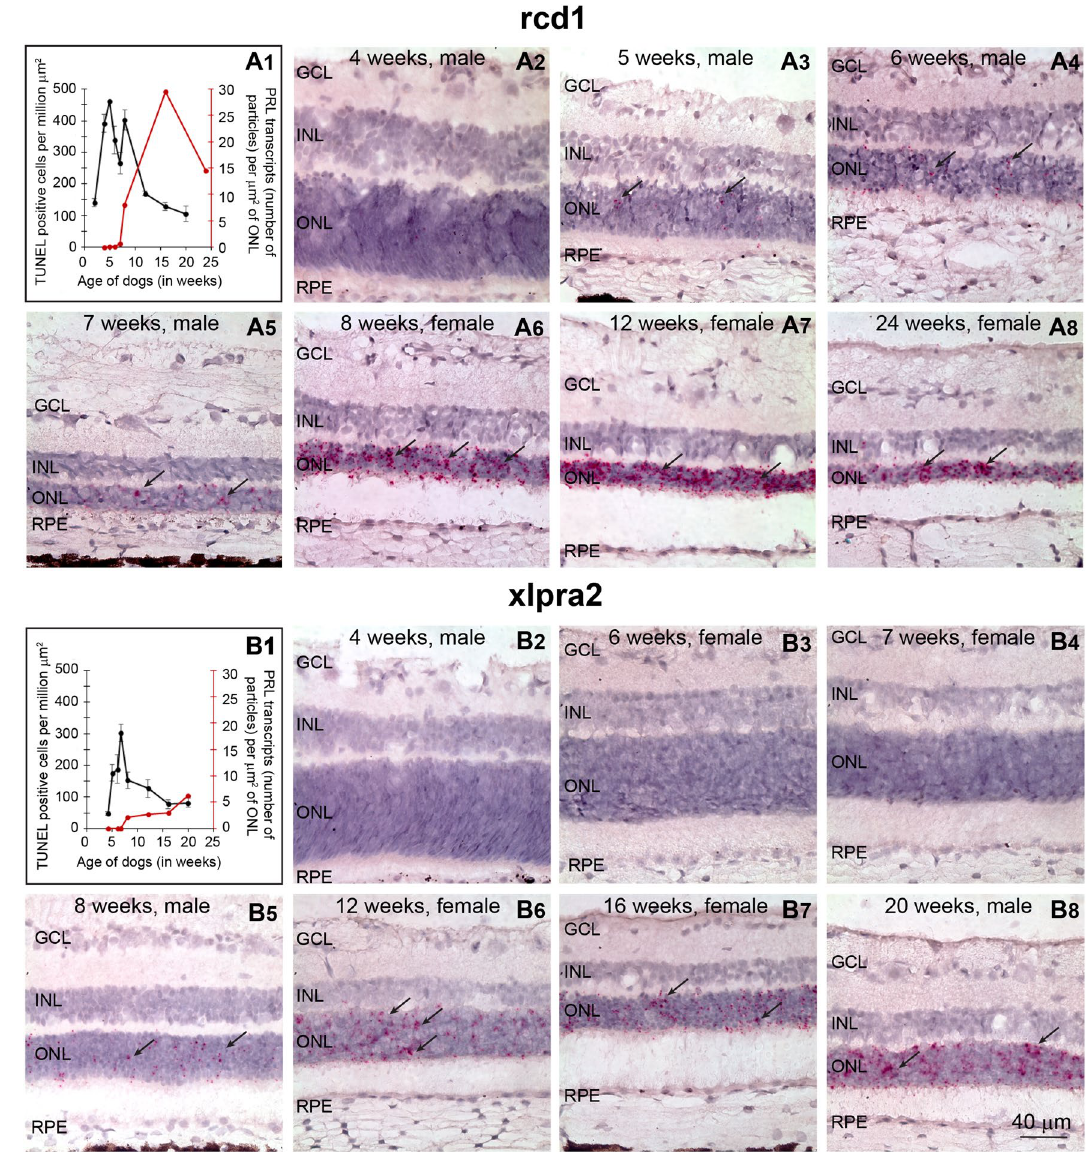
Figure 4. Early onset and increasing expression of PRL mRNA with progression of retinal degeneration in dogs. (A1) Black line: TUNEL positive photoreceptors measured in the superior/tapetal retina as a function of age in rcd1 dogs. Figure modified from a previous publication 37 Red line: Quantitation of number of PRL particles detected by RNA-ISH as a function of age in xlpra2 dogs. (A2–8) RNA-ISH on cryosections from archival retinal OCT tissue blocks showing expression of PRL mRNA in the ONL of rcd1 dogs at various ages (n = 1 dog per age). (B1) Black line: TUNEL positive photoreceptors measured in the superior/tapetal retina as a function of age in xlpra2 dogs. Figure modified from a previous publication 38 . Red line: Quantitation of number of PRL particles detected by RNA-ISH as a function of age in xlpra2 dogs. (B2–8) RNA-ISH on cryosections from archival retinal OCT tissue blocks showing expression of PRL mRNA in the ONL of xlpra2 dogs at various ages (n = 1 dog per age). For comparison, the number of TUNEL positive cells per million µm 2 of ONL ranges from 0–15 in normal dogs 37,38